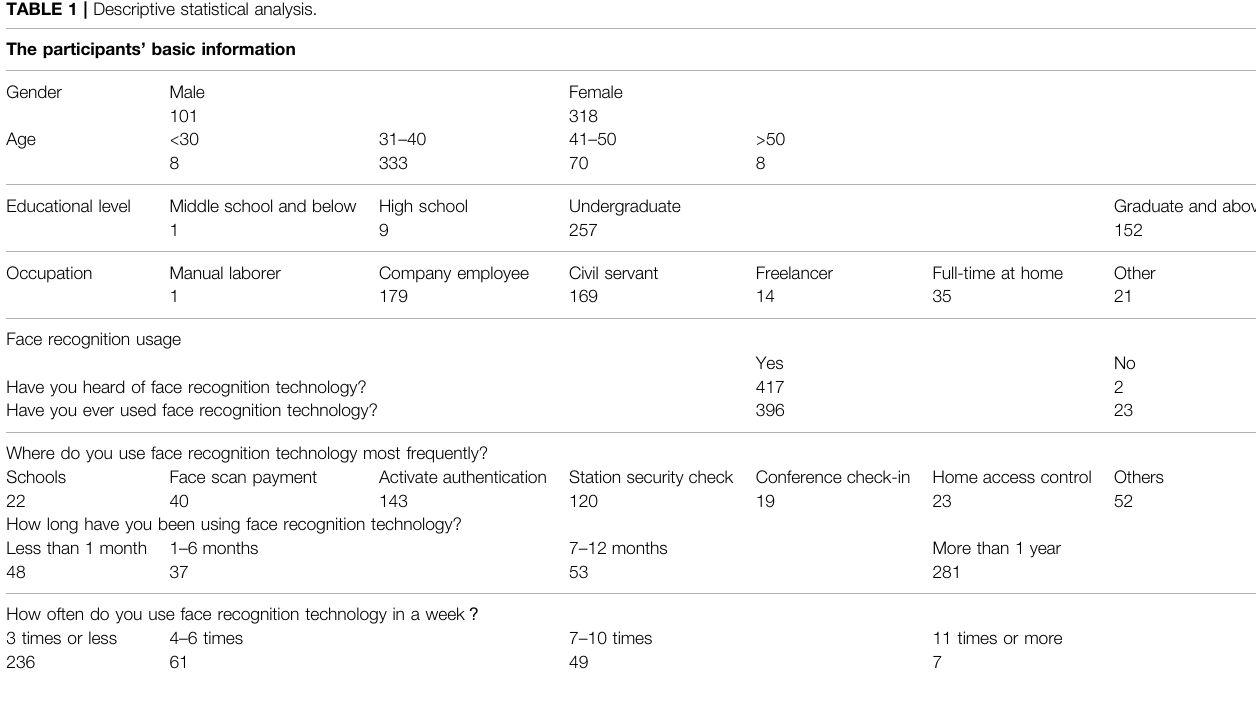
TABLE 1 | Descriptive statistical